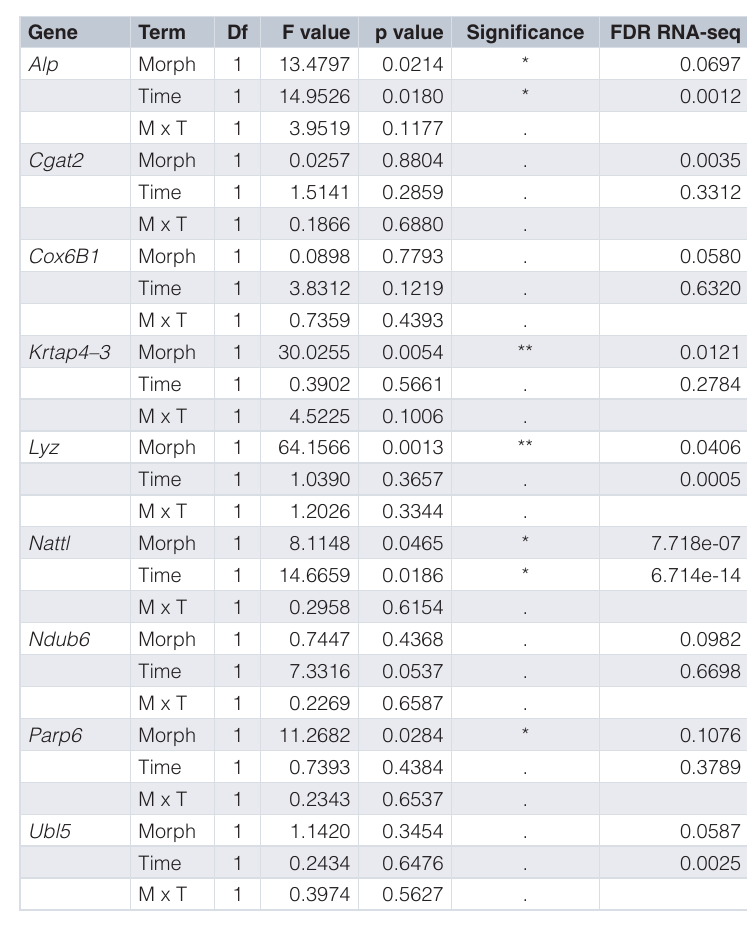
Supplemental Table S4. ANOVAs on qPCR data. Expression of nine genes was analyzed in whole SB- and AC-charr embryos, at two developmental timepoints (161 and 200 τ s